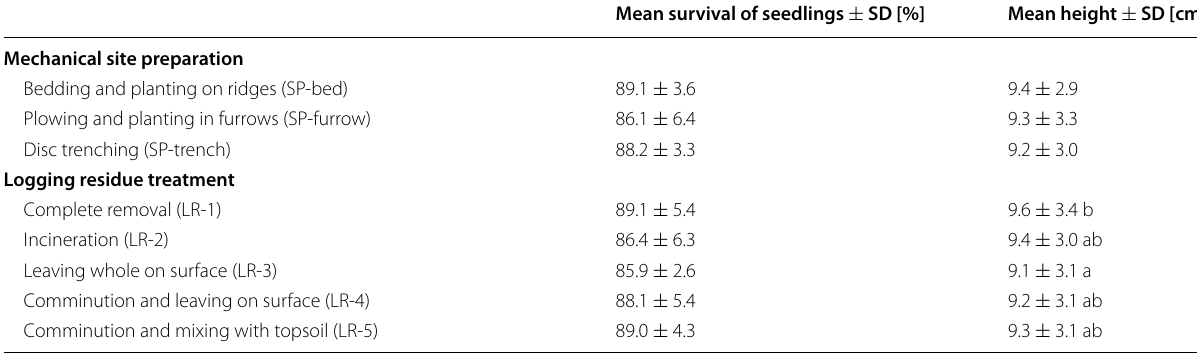
Table 2 Survival and height of Scots pine seedlings 1 year after planting. Different letters indicate significant differences in tree heights among the logging residue treatments ( p < 0.05)